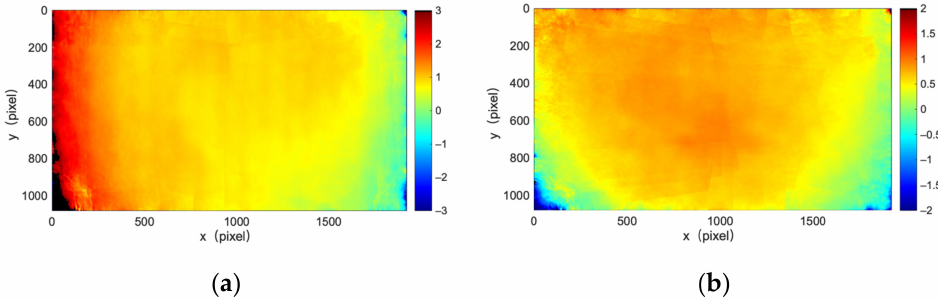
Figure 2. ( a ) Distortion rectification map of point-to-point calibration method subtracted from distortion rectification map of Zhang’s calibration method for X directions; ( b ) Distortion rectification map of point-to-point calibration method subtracted from distortion rectification map of Zhang’s calibration method for Y